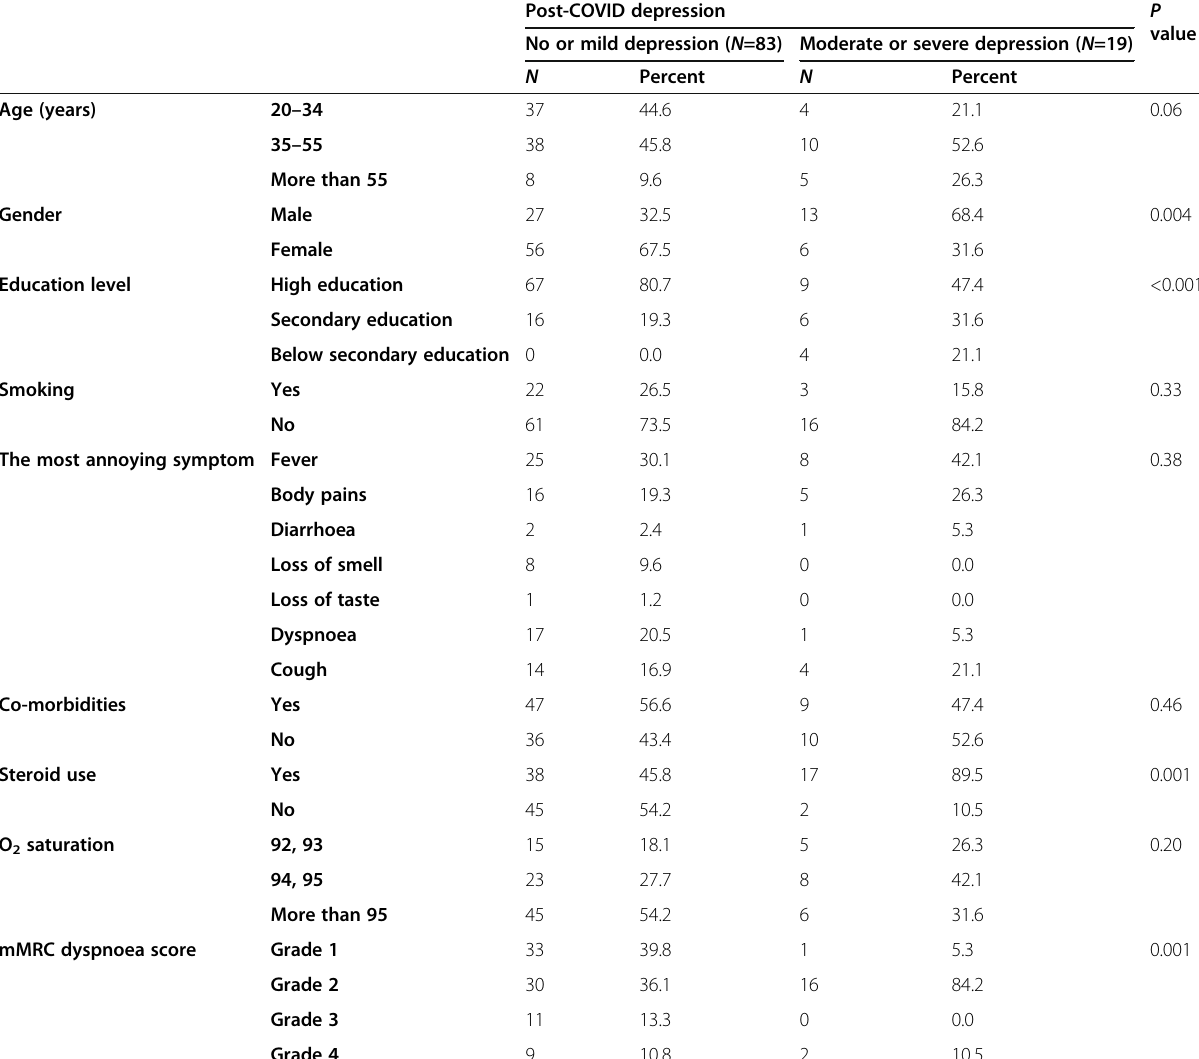
Table 2 Factors associated with post-COVID depression